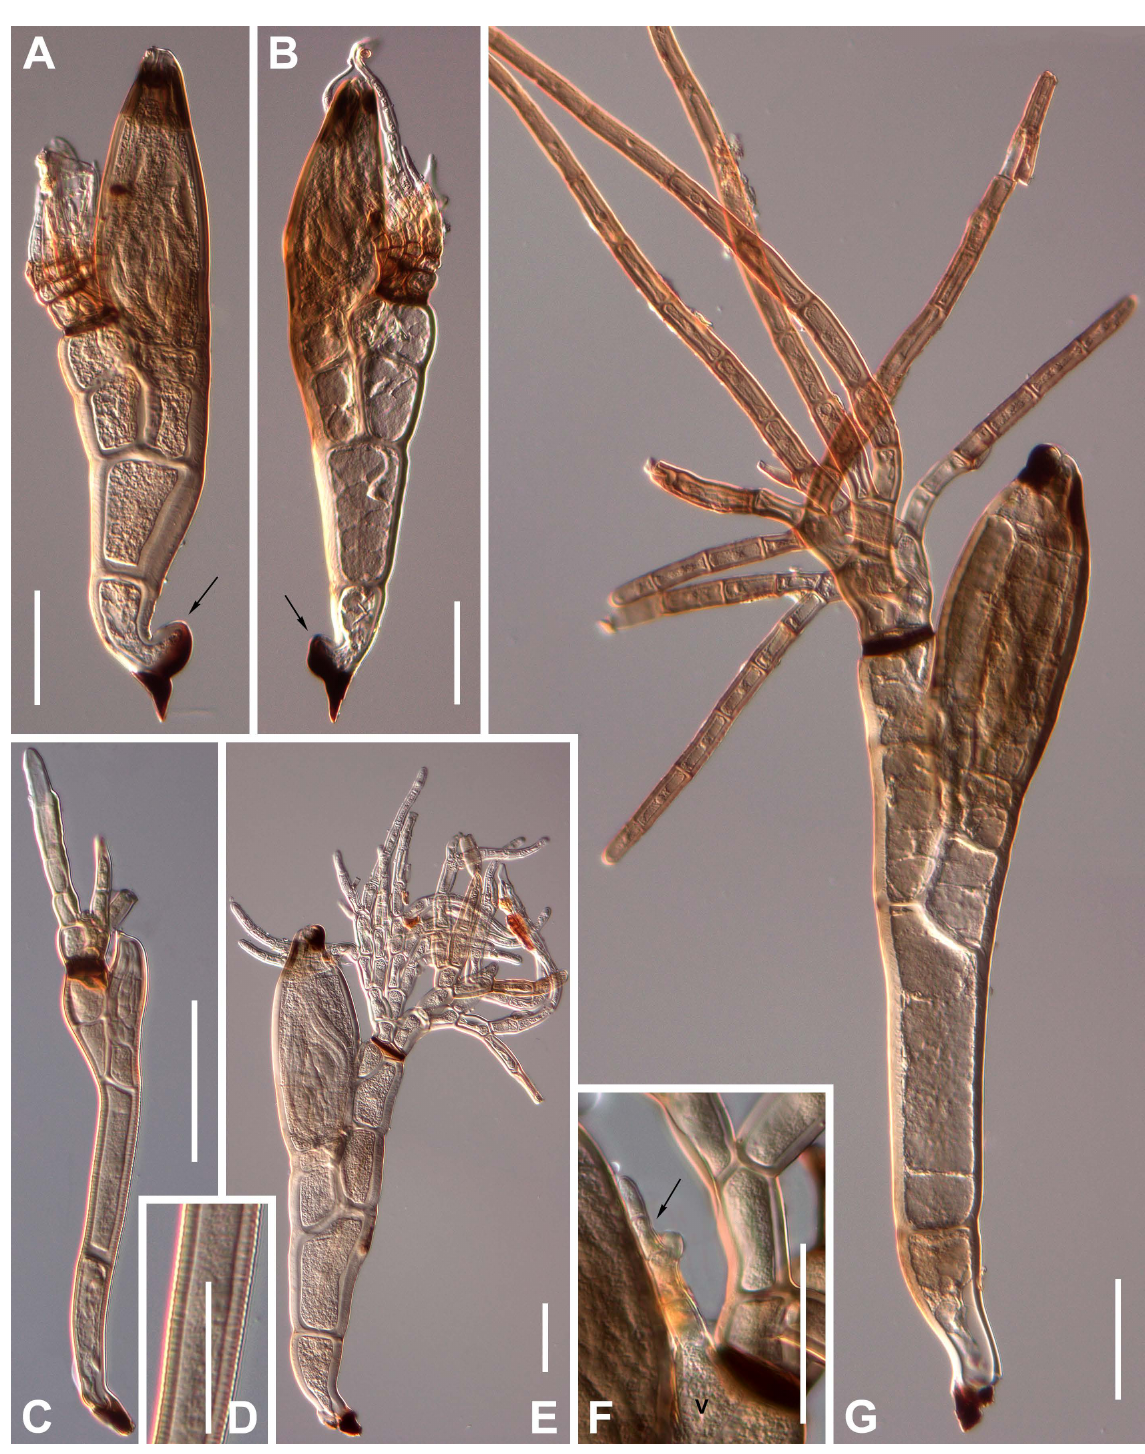
Fig. 41. Laboulbenia spp. A – B . L. philonthi Thaxt. Mature thalli showing blackish lateral swelling above the foot (arrows). – C – D . L. picardii Maire. C . Immature thallus. D . Corrugation of cell II margins in detail. – E – G . L. pseudomasei Thaxt. E , G . Mature thalli. F . Branch (arrow) from cell V in detail. Scale bars: A–C, E–G = 50 µm; D = 25 µm. Photographs from slides ZMUC C-F-123094 (A–B), ZMUC C-F- 123456 (C–D), ZMUC C-F-122782 (E), ZMUC C-F-122742 (F), ZMUC C-F-122740